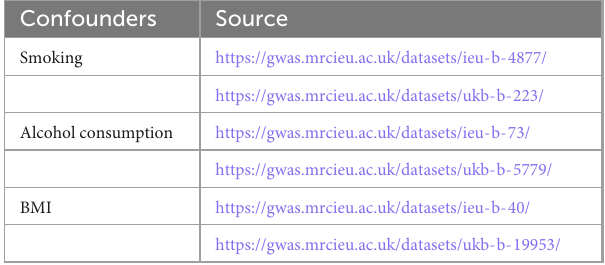
TABLE 2 Source of the